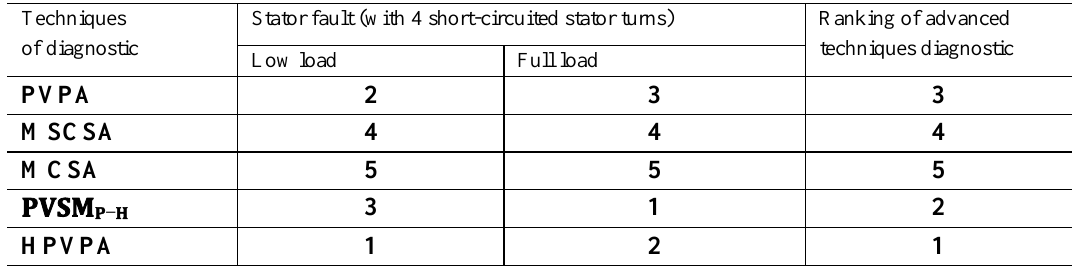
Table 1. Classification of diagnostic techniques according to their experimental sensitivities Techniques of